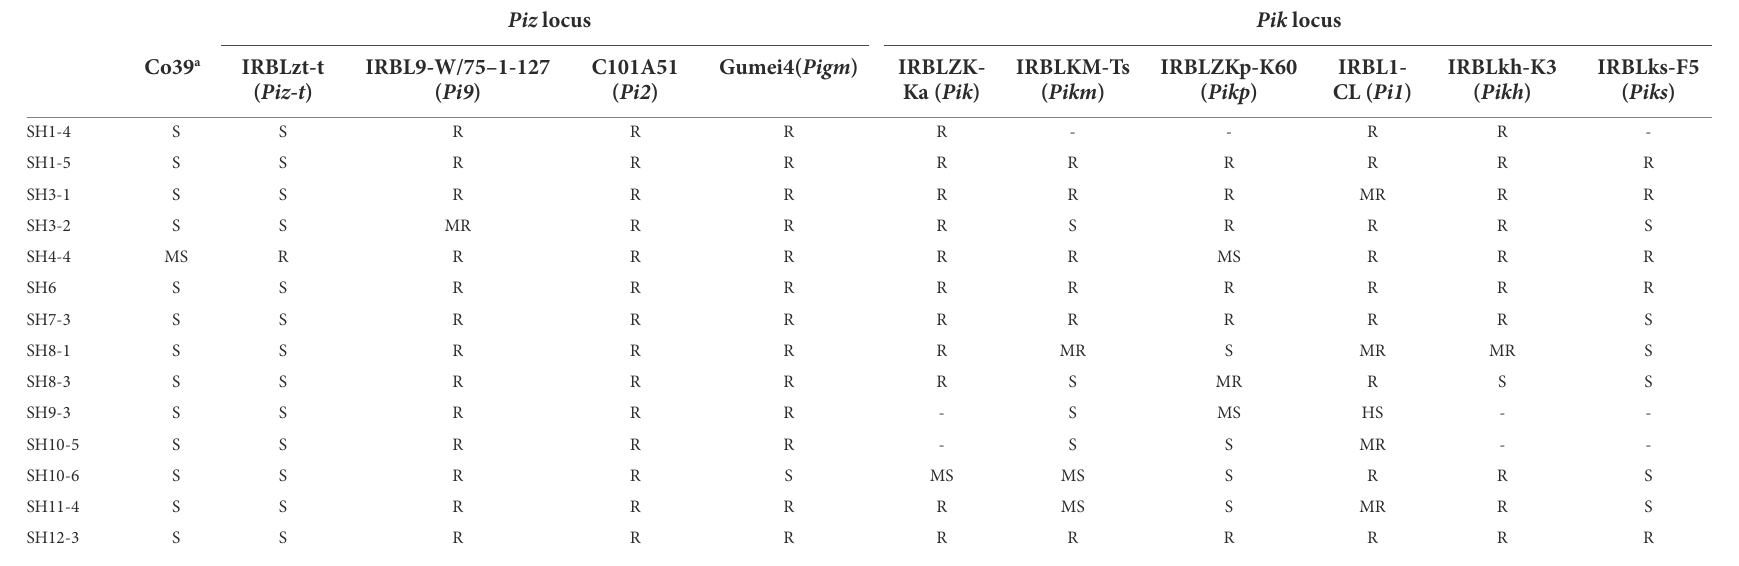
TABLE 2 Pathotypes of 10 mono-genic lines against 14 representative local